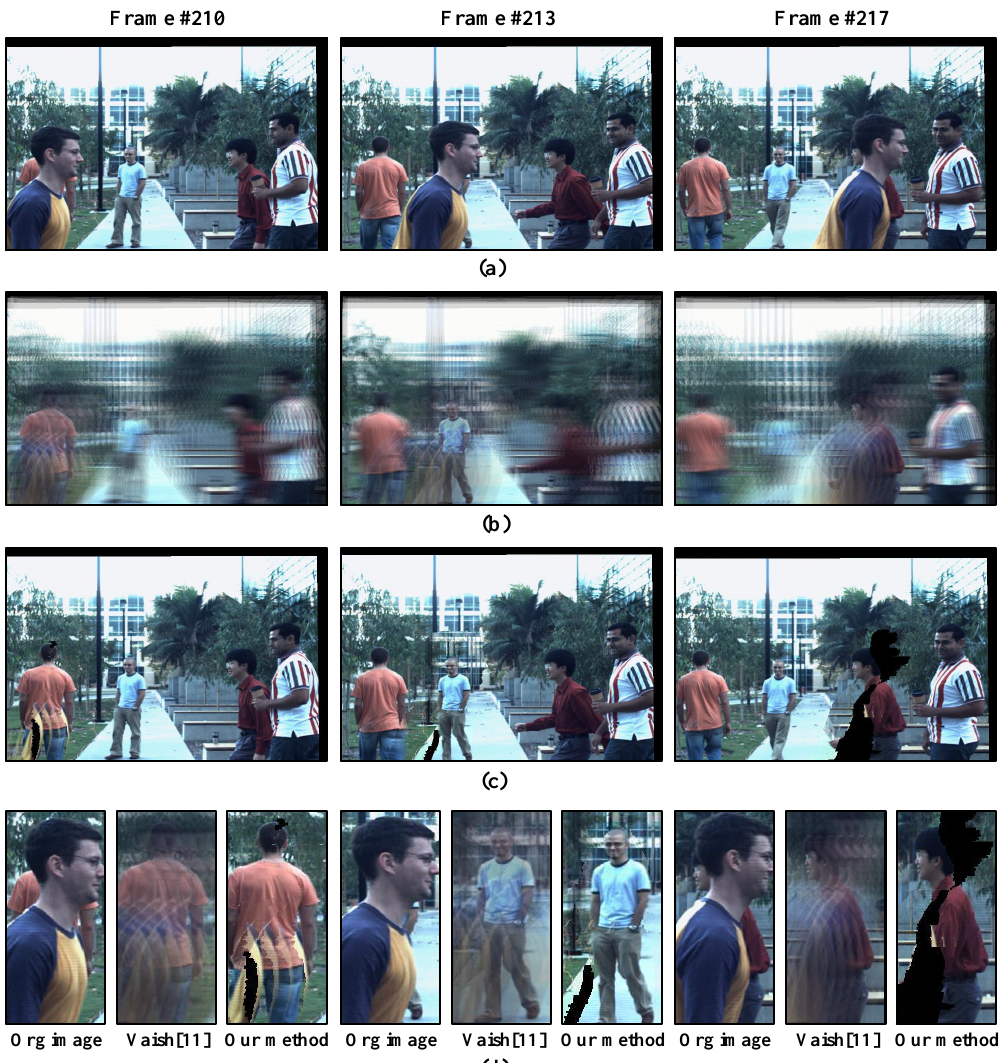
Figure 7. Comparison results on crowd surveillance data from UCSD light field data. ( a ) Original sequences of reference camera view; ( b ) Occluded object imaging result of Vaish et al. [11]; ( c ) Occluded object imaging result by our method; ( d ) Comparison of local